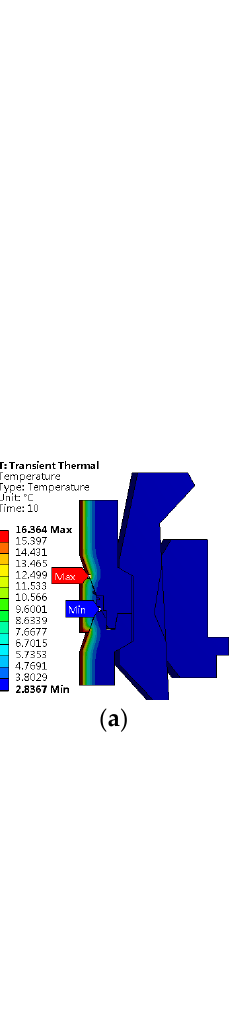
Table 5. The time required for each component to generate a temperature peak under the working condition of temperature